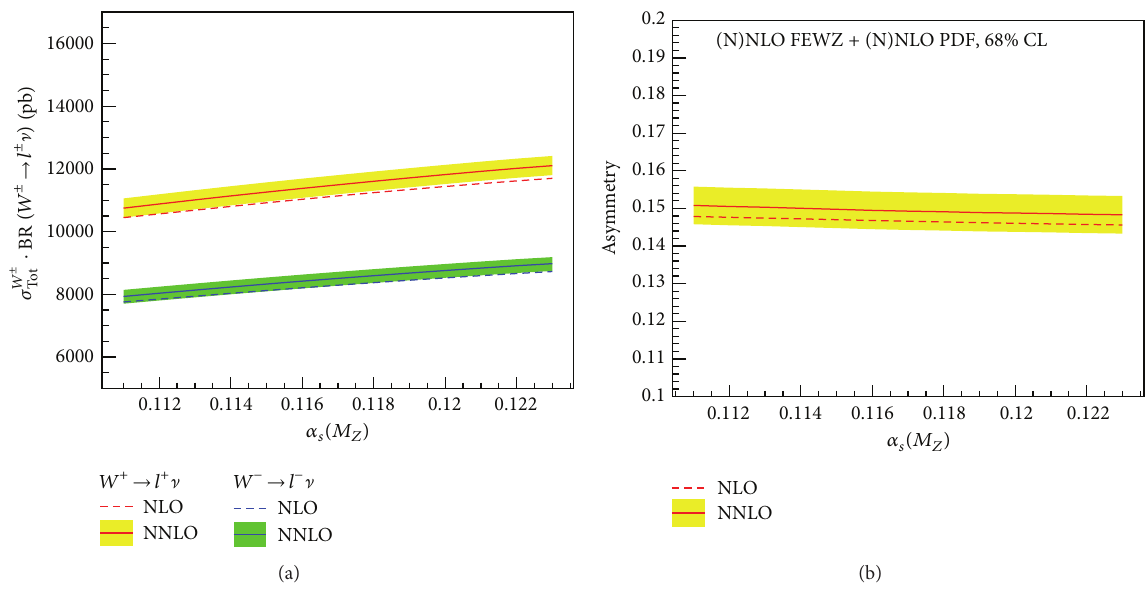
Figure3: 𝑊 ± (𝑙 ± ] ) totalcrosssectionsandtheleptonchargeasymmetrypredictionsasafunctionof 𝛼 𝑠 withNLOandNNLOQCDcorrections at √𝑠 = 13 TeV. The predictions are computed using CT14 NLO and NNLO PDF